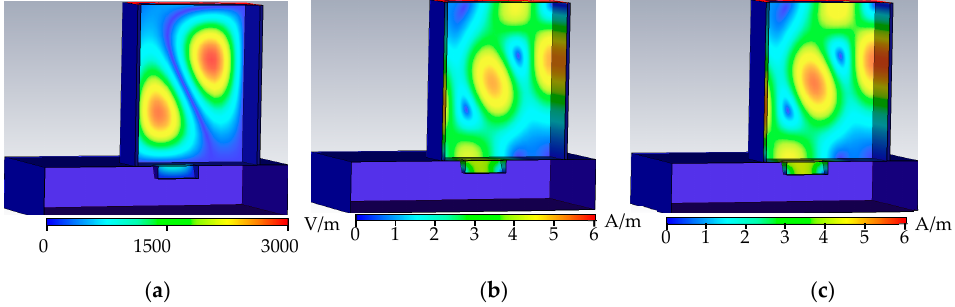
Figure 6. Triangular defect field distribution. ( a ) Trapezoid defect electric field distribution. ( b ) Trapezoid defect magnetic field distribution. ( c ) Trapezoid defect wall current distribution.